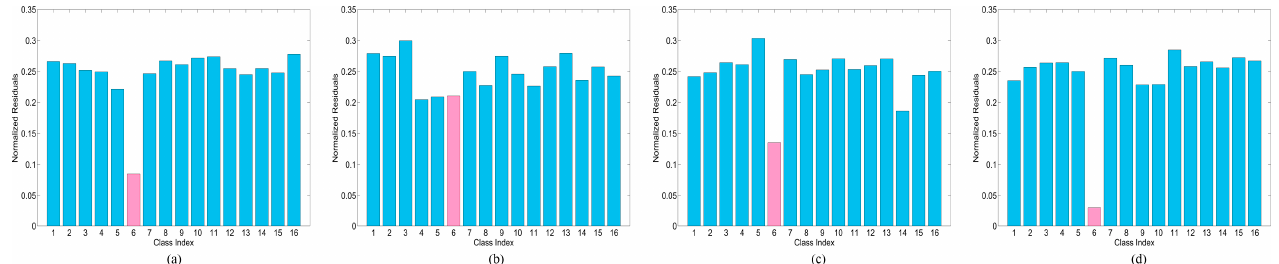
Figure 10. Representation coefficients of a test sample from class 6 in the Indian Pines data set using 10 training samples per class for the MFCARC algorithm. ( a ) Spectral. ( b ) Gabor. ( c ) Differential morphological profile (DMP). ( d ) Local binary pattern (LBP).